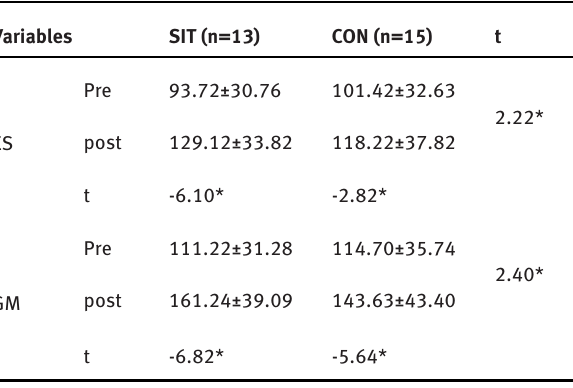
SIT = sensory integration balance training group, CON = control group, ES = erector spinae, GM = gluteus medius, *p<0.05